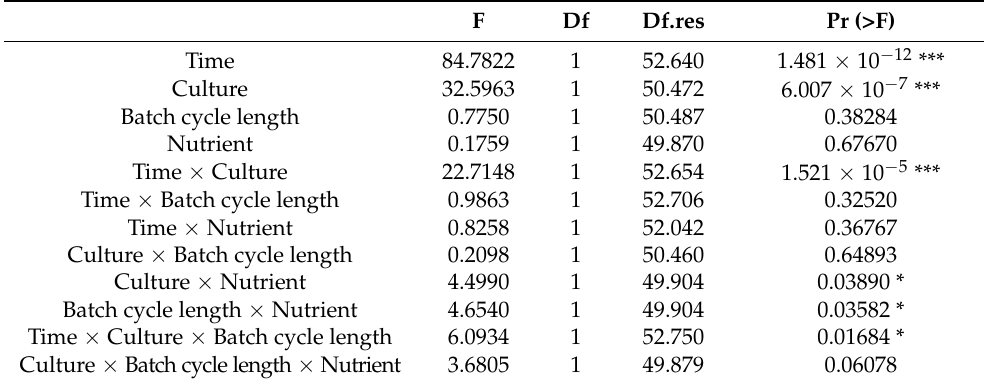
Table 2. Analysis of deviance table of Type II Wald F tests with Kenward-Roger df for linear mixed- effects model with Shannon’s diversity index of E. huxleyi as response variable. Stars show significance level of the test; *** p < 0.001 and * p < 0.05.